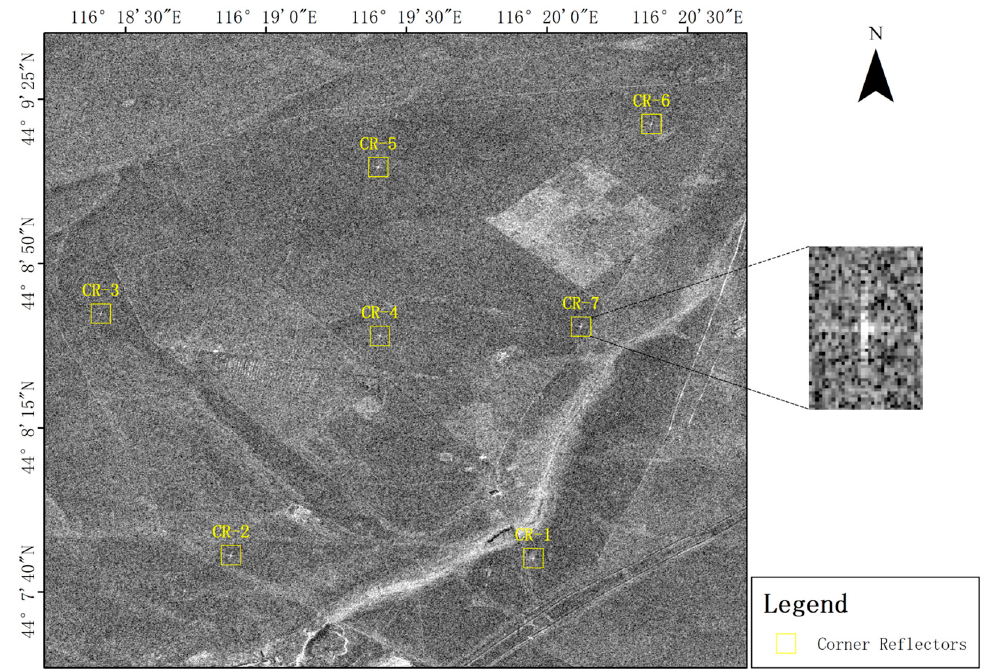
Figure 5. Geocoded backscattering coefficient products.